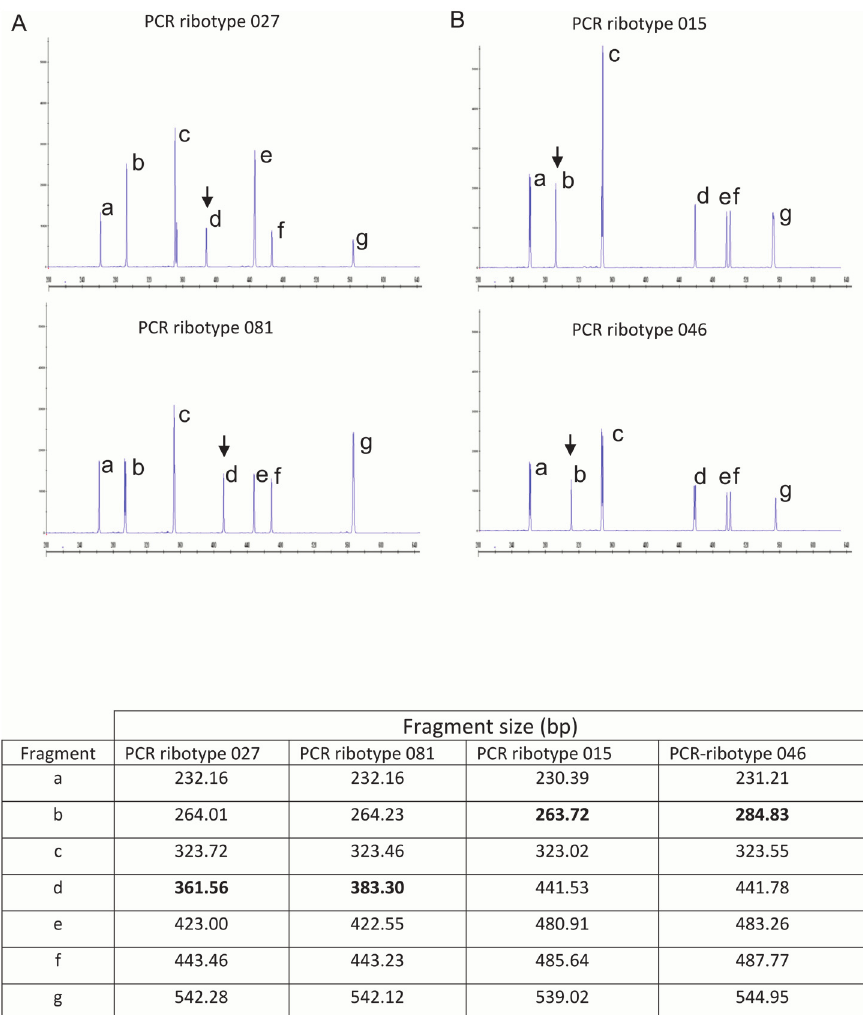
Fig 2. PCR-ribotypes with very similar profiles: (a) ribotypes 027 and 081 and (b) ribotypes 015 and 046. PCR-ribotypes 027 and 081 differ from one another by only a ~20bp difference at position d. Similarly PCR-ribotypes 015 and 046 differ by only a ~20bp difference at position b. Discriminating features between these very similar profiles are indicated (arrows) and associated fragment sizes are highlighted in bold. Relative fragment size was the only parameter used to discriminate between ribotype profiles. Relative peak heights (relative fluorescent units, y-axis) within profiles lacked reproducibility for some ribotypes and therefore this parameter was not